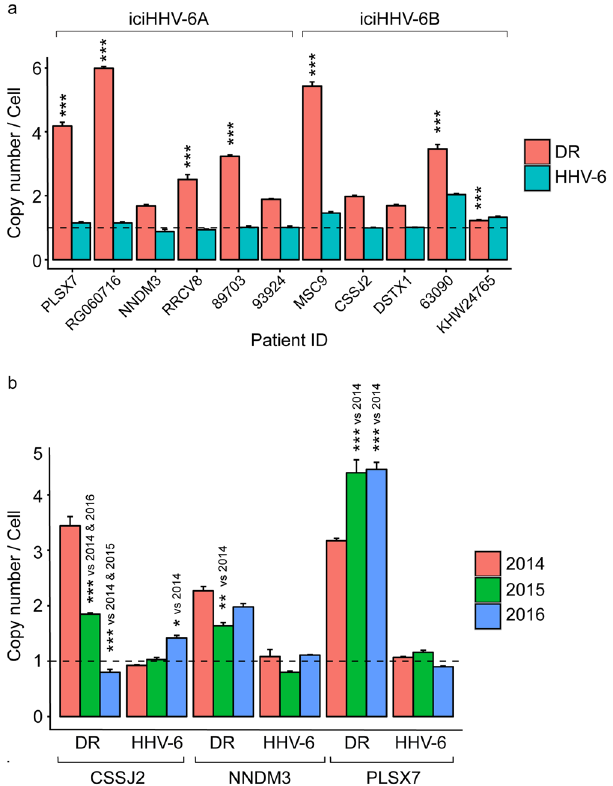
Figure 1. High number viral DRs are detected in many iciHHV-6 individuals. ( a ) Number of copies of HHV-6 genome and viral DR per cell were quantified using qPCR. HHV-6 and DR copy numbers for different individuals were compared against patient 93924 for statistical analysis as 93924 had ~1 copy of HHV-6A and ~2 copies of DR representing the most ideal scenario. ( b ) Viral genome copy numbers and DR copy numbers were quantified over a period of 3 years in 3 different iciHHV-6 individuals. Data represents mean values of 3 different biological triplicates. Statistical analysis was done by using two-way Analysis of Variance (ANOVA) followed by Tukey’s Honest Significance Differences (HSD) test for determination of individual comparisons, adjusted P values. * < 0.05, ** < 0.01, *** < 0.001. Copy number of 1 is marked as a baseline (dotted